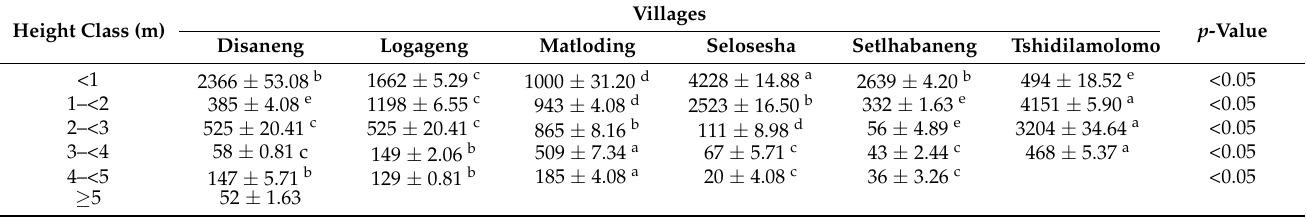
Table 2. Mean density (TE ha − 1 ) ± SE of woody plants in different height classes around the six villages.